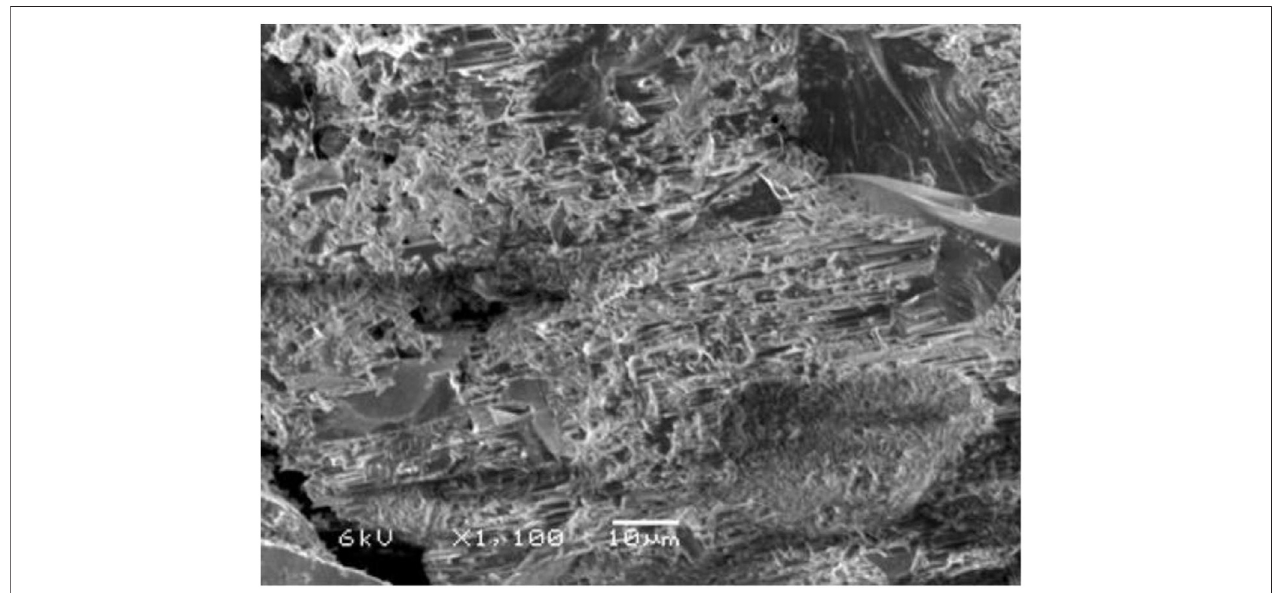
FIGURE 5 | The SEM micrograph of the tested CPB